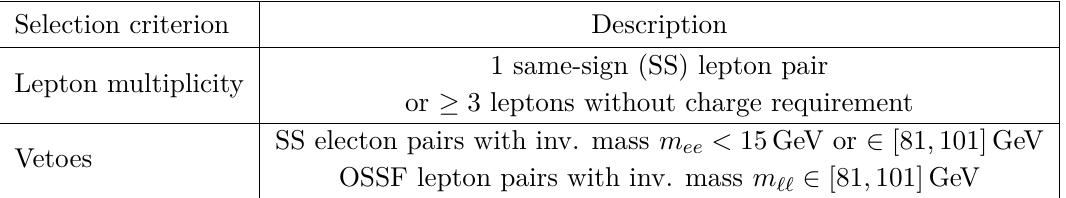
Table 2 . Summary of common selection criteria for ATLAS-CONF-2020-013, reproduced in full from section 3 of [3].